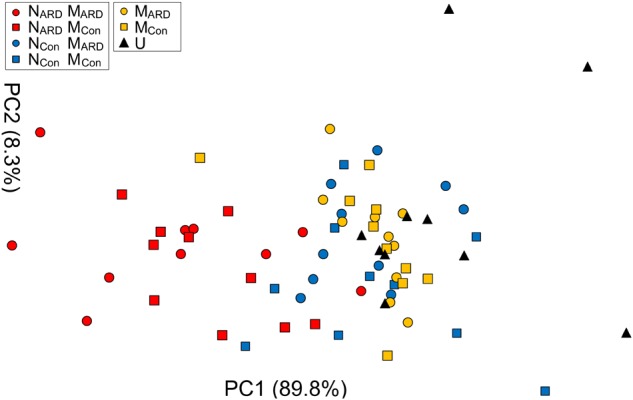
Apple plant growth affected by nematodes from ARD plots (NARD) or control plots (NCon), and microbes from ARD plots (MARD) or control plots (MCon), and non-inoculated control (U). The first two principal components extracted from the parameters root weight, shoot weight, shoot length, weight of leaves, and number of leaves 8 weeks after inoculation were plotted (PC1 and PC2 with the explained percentage of variance, respectively).